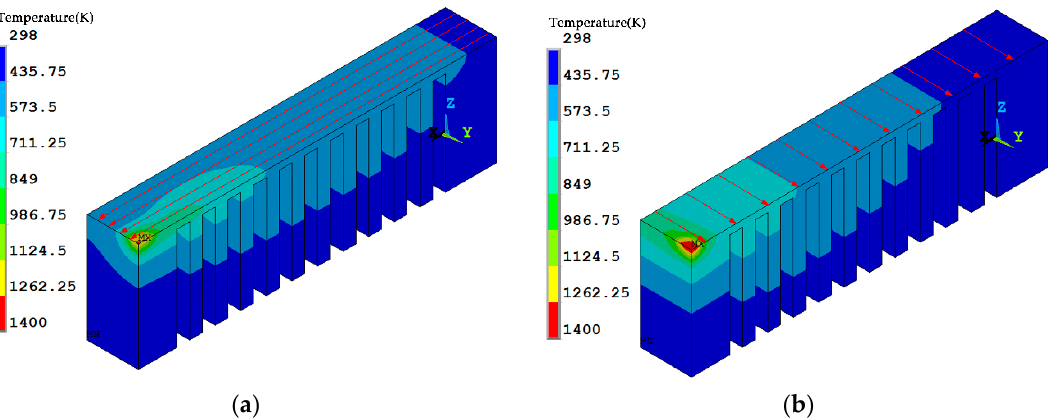
Figure 8. Temperature distribution under different scanning strategies at the end of laser scanning: ( a ) the x scanning route; and, ( b ) the y scanning route.